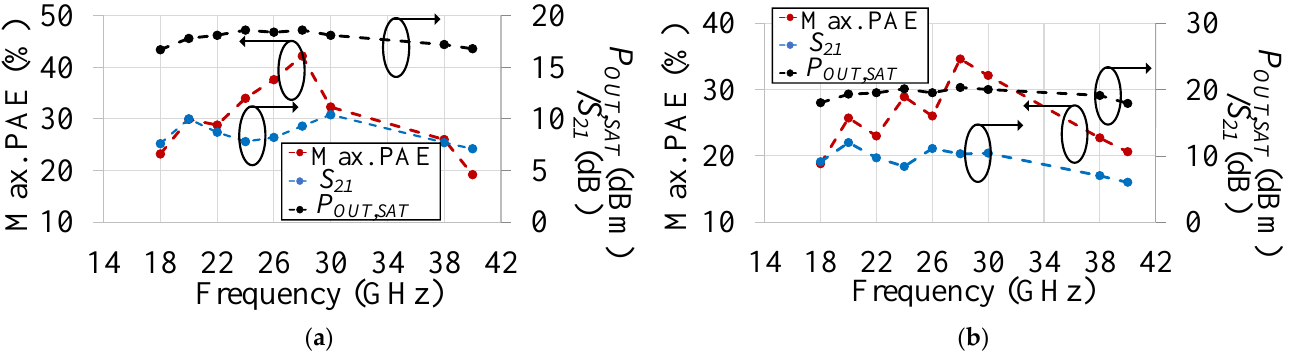
Figure 6. Measured maximum PAE, S 21 and P OUT,SAT vs. frequency of the broadband single-ended GaN PA at ( a ) V DD = 4 V and ( b ) V DD = 6 V. PA Linearity is then tested with 50, 100, 400, and 9 × 100 MHz 256-QAM-modulated 5G NR inputs at PAPR (peak-to-average-power ratio) = 8.0 dB at 24 GHz and V DD = 4 V (Figure 7). With P OUT,AVE = ~11 dBm, this PA achieves ACLR − /+ (adjacent channel leakage ratio) of − 27.6/ − 27.0 dBc with BW = 50 MHz ( PAE AVE = 13.3%), − 27.4/ − 27.2 dBc with BW = 100 MHz ( PAE AVE = 12.1%), − 26.7/ − 26.8 dBc with BW = 400 MHz ( PAE AVE = 11.8%), and − 25.5/ − 26.0 dBc with BW = 9 × 100 MHz ( PAE AVE = 12.0%). The signal BW is varied from 50 – 900 MHz at 24, 28, 37, and 39 GHz, and the measured ACLR vs. BW is plotted in Figure 8 all at P OUT,AVE ~11 dBm when V DD = 4 V, and P OUT,AVE = ~12 dBm with V DD = 6 V. Figure 8 shows that there is not a significant degradation in the PA linearity increasing the 5G NR signal BW from 50 MHz to 9 × 100 MHz at 28, 37, and 39 GHz, and only a slight degradation (~2 dBc) in the measured ACLR at 24 GHz for both V DD = 4 V and 6 V. Additionally, there is minimal degradation on the linear output power, increasing from 24/28 GHz to 37/39 GHz.